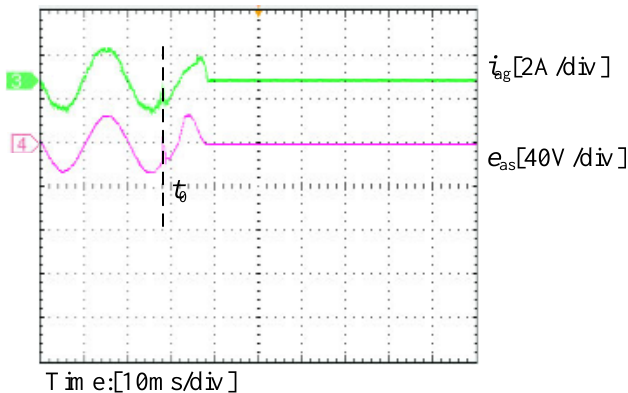
Figure 11. The experimental results with the inductive load.